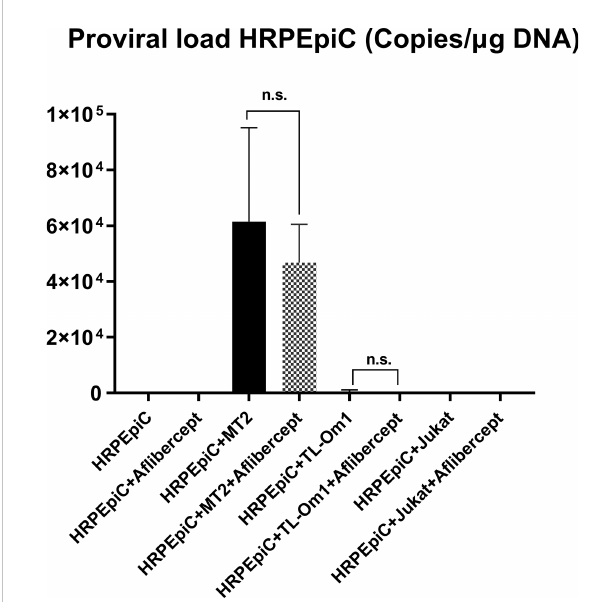
FIGURE 6 HTLV-1 proviral DNA (PVL) was monitored in HRPEpiCs transferred three times after culture alone or co-culture with MT2, TL-Om1, or Jurkat cells. A fl ibercept had no effect on HTLV-1 PVL of HRPEpiCs in the corresponding groups. The number of each type of cells was 1 × 10 5 . Data are taken from three independent biological experiments. Error bars represent standard deviation (n.s., not signi fi cant).